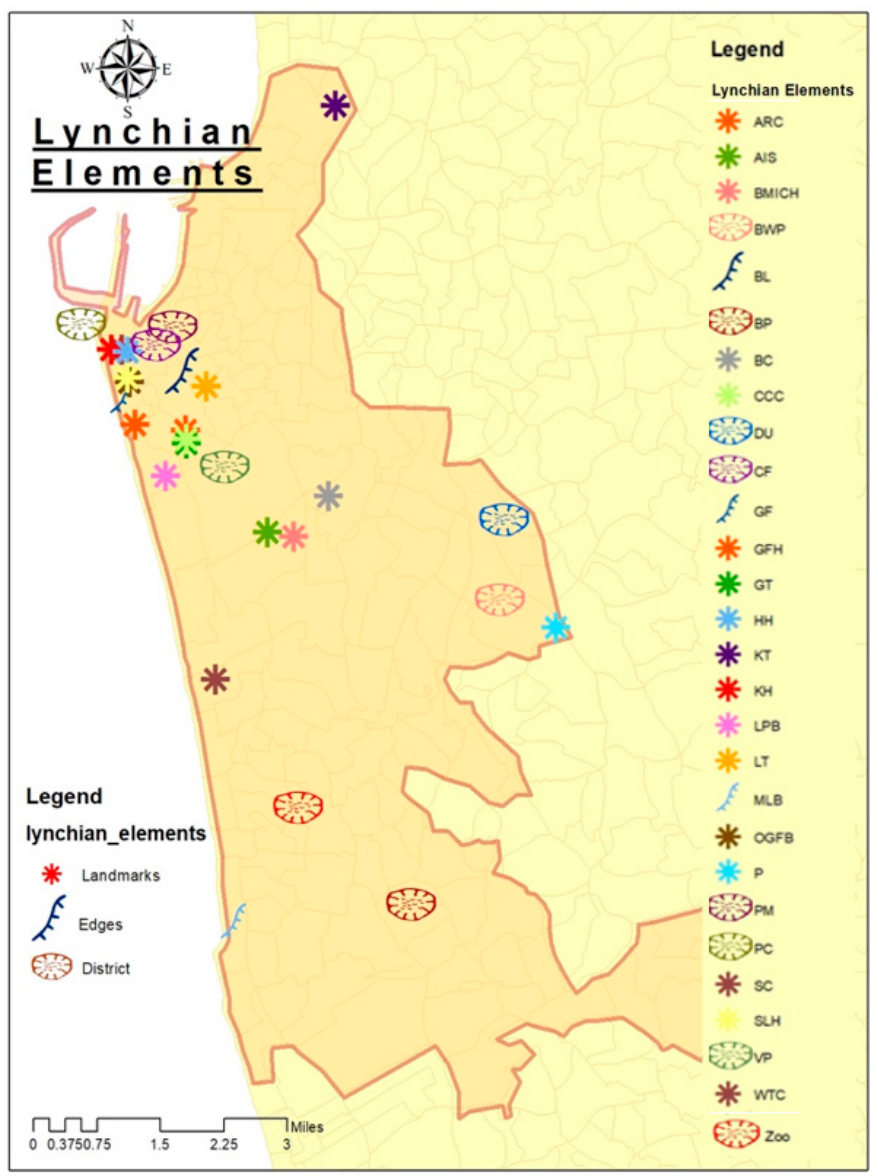
Figure 4. Distribution of place names according to the Lynchian category.